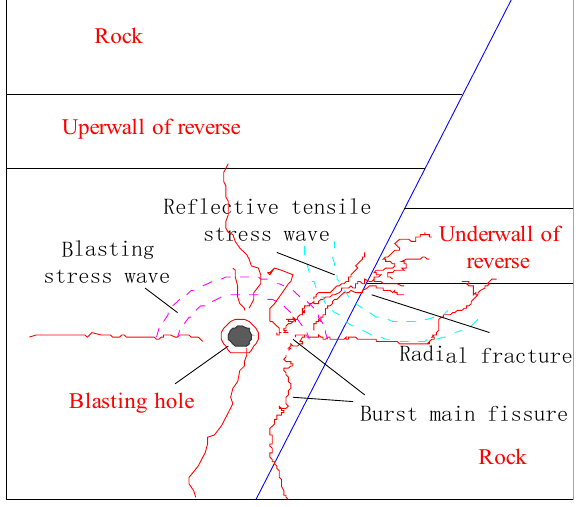
Figure 18. Schematic of the propagation of a blasting stress wave within a reverse